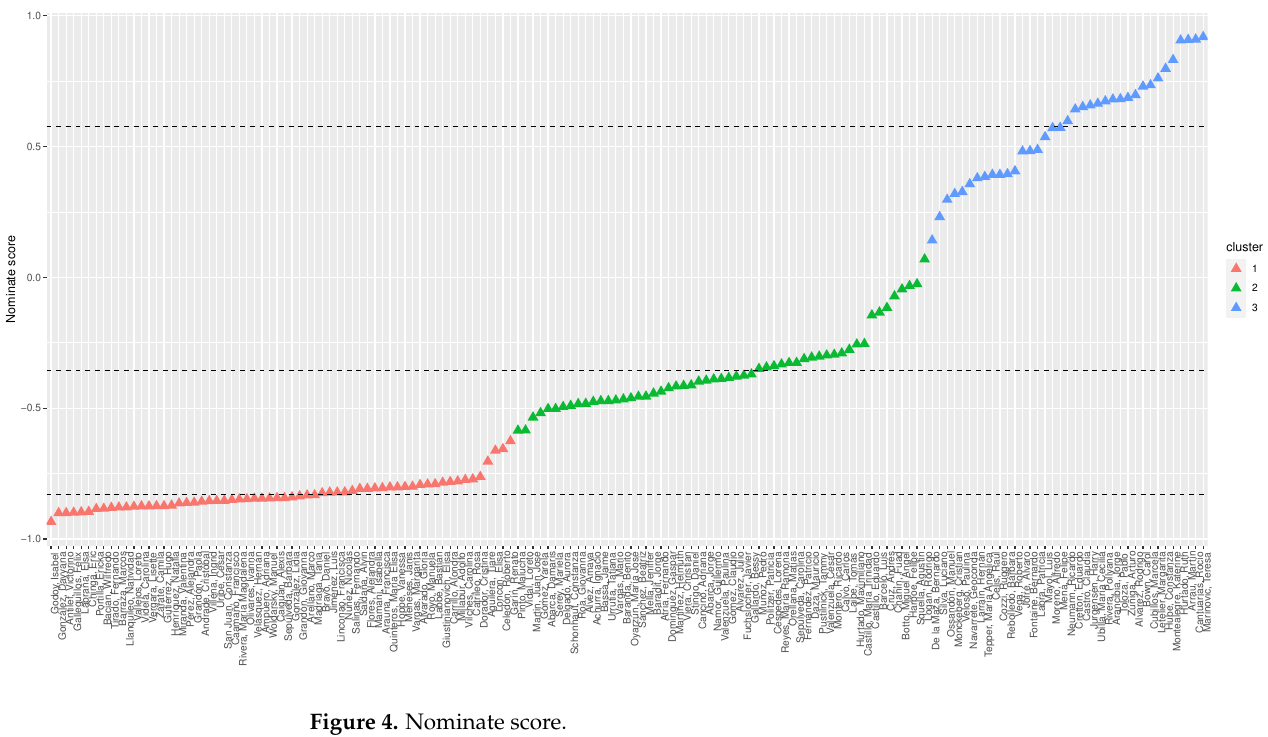
Figure 4. Nominate score.